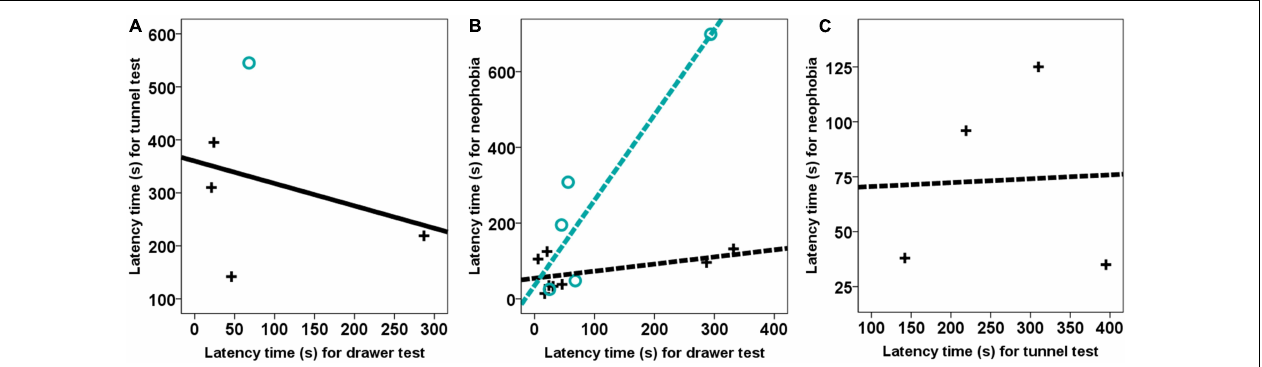
FIGURE 3 | Relationship between neophobia and performance in problem-solving tests of temporarily captive adult individuals of the Chiguanco Thrush. (A) Drawer test vs. tunnel test, (B) Drawer test vs. neophobia, and (C) Tunnel test vs. neophobia. Black crosses and black dotted fit line for urban individuals, open green circles and green dotted fit line for extra-urban individuals, and solid black fit line for urban and extra-urban individuals